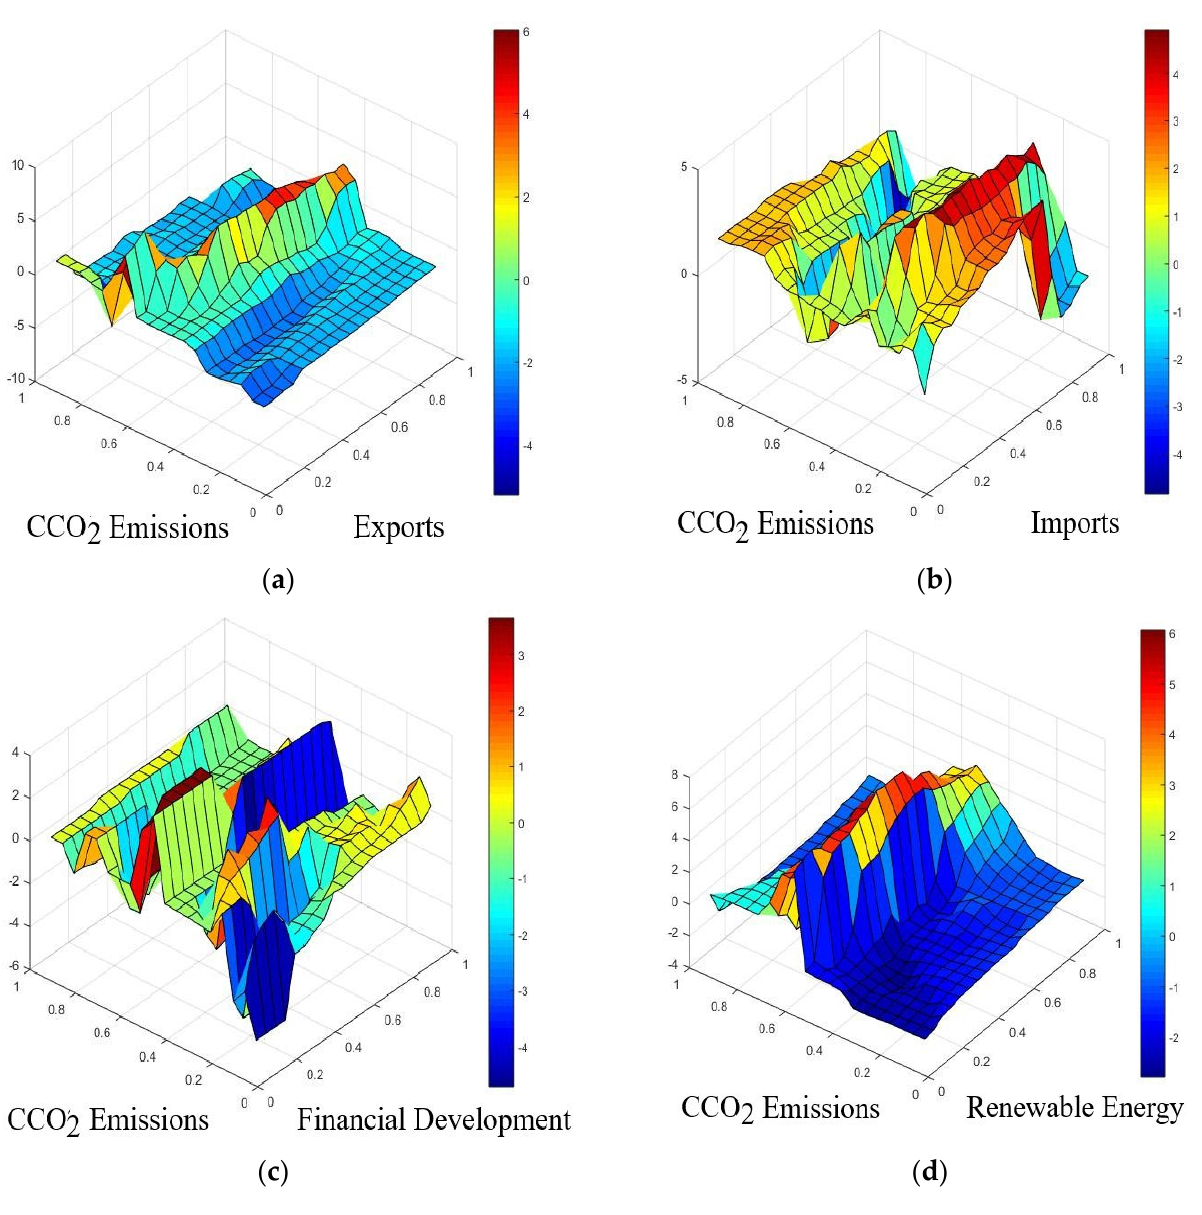
Figure 1. ( a ) Impact of EXP on CCO 2 e; ( b ) impact of IMP on CCO 2 e; ( c ) impact of FD on CCO 2 e; ( d ) impact of REC on CCO 2 e.